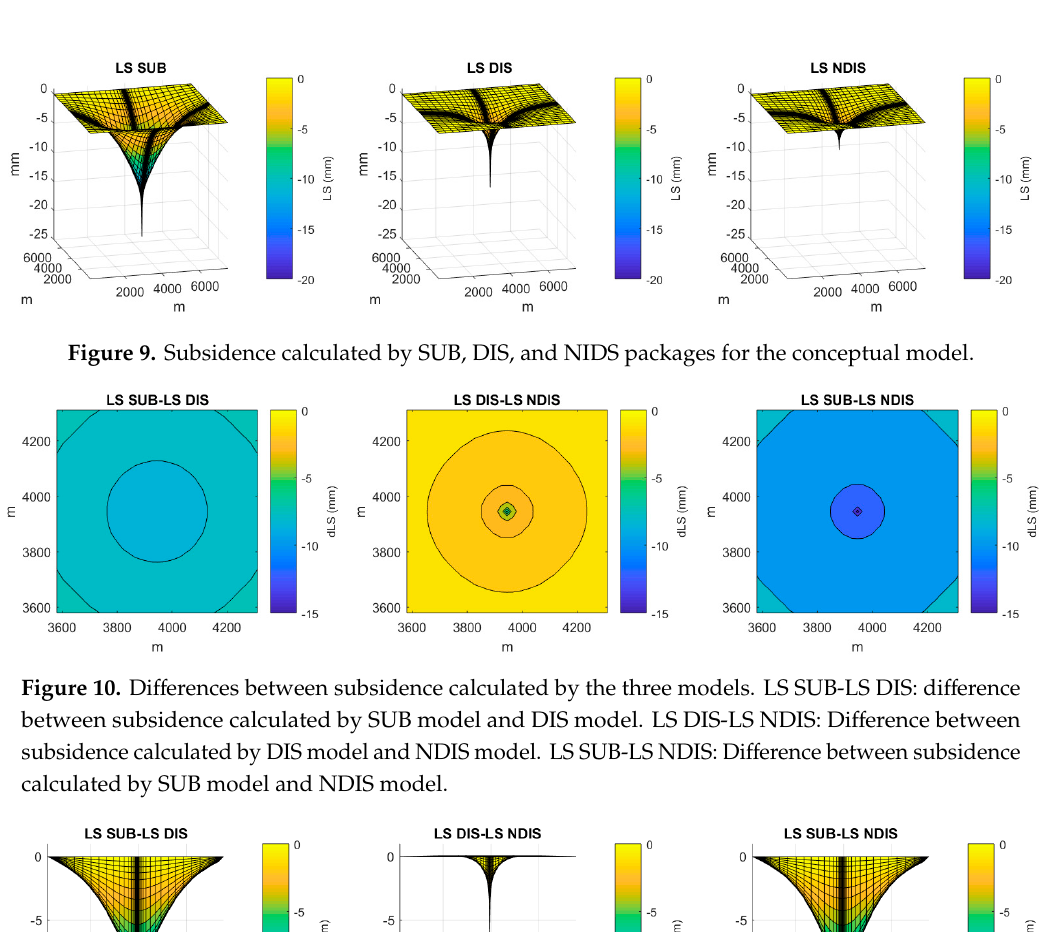
Figure 8. Change in hydraulic conductivity and specific storage at the top (layer 8), middle (layer 10), and bottom (layer 12) of the second confining layer, unit D. A homogeneous highly compressible formation, unit D in this case, is transformed to a horizontally and vertically heterogenous one.